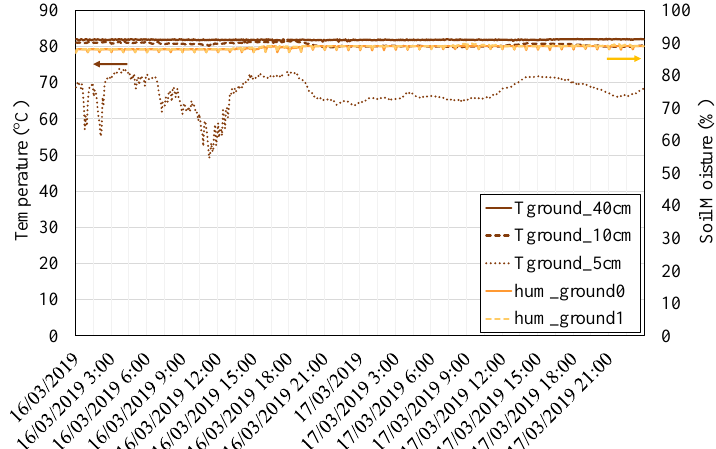
Figure 10. Ground temperature at a depth of 5cm (dotted brown line), 10cm (dashed brown line), and 40cm (filled brown line) on the left axis, and soil moisture at a depth of 40cm on the right axis (orange and yellow